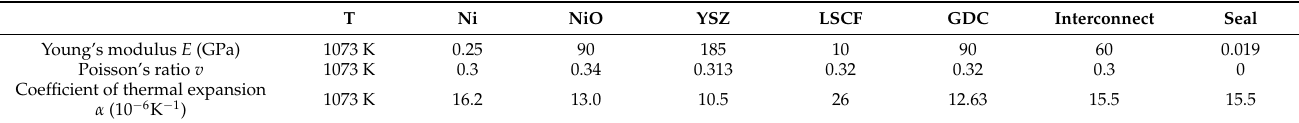
Table 5. Parameters for the thermal stress analysis of an SOFC [10,12].